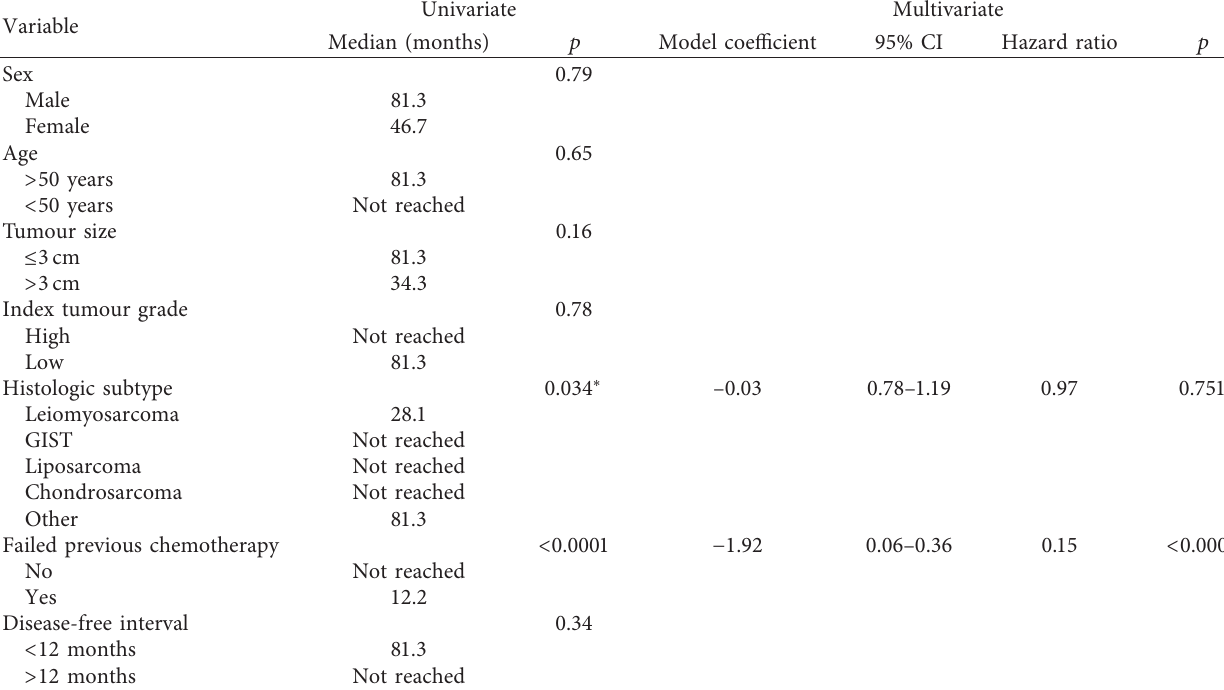
Table 4: Cytotoxic chemotherapy-free interval in sarcoma patients undergoing